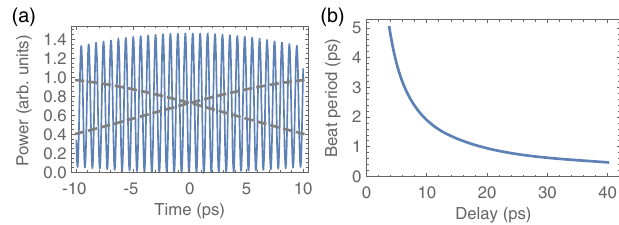
FIG. 13. (a) Laser power profile for two copies of a linearly chirped Gaussian pulse with 43-ps FWHM duration, wavelength of 1030 nm, and FWHM bandwidth of 8 nm, with 29-ps delay between pulses. The dashed lines show the power profiles if one of the pulses was blocked. (b) The node spacing decreases with increasing pulse separation.